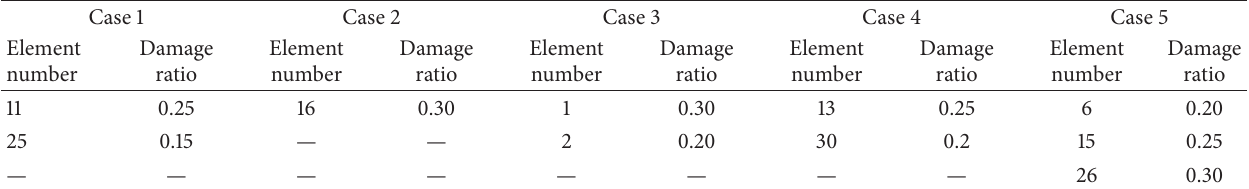
Table 1: Five different damage cases induced in 31-bar planar truss.